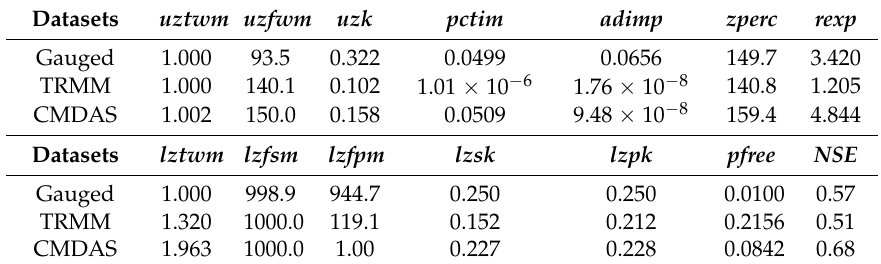
Table 6. Calibrated optimal parameter sets and daily NSE values for each precipitation dataset applied to the Sacramento model